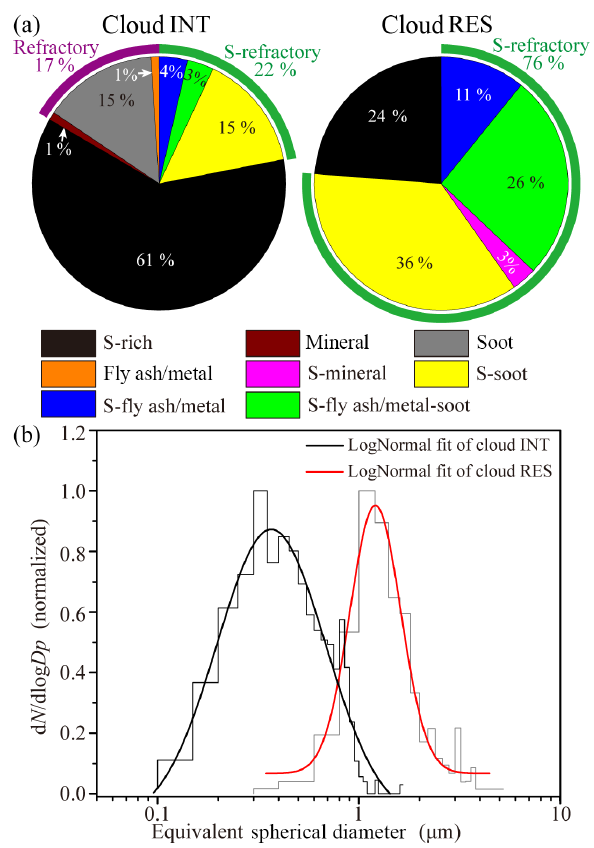
Figure 7. Number fractions of different particle types in cloud RES and INT particles (a) and size distributions of cloud RES and cloud INT particles (b) . The measured particle sizes exclude the effects of water rims in TEM images. In total, 292 cloud RES and 1161 cloud INT particles were analyzed.